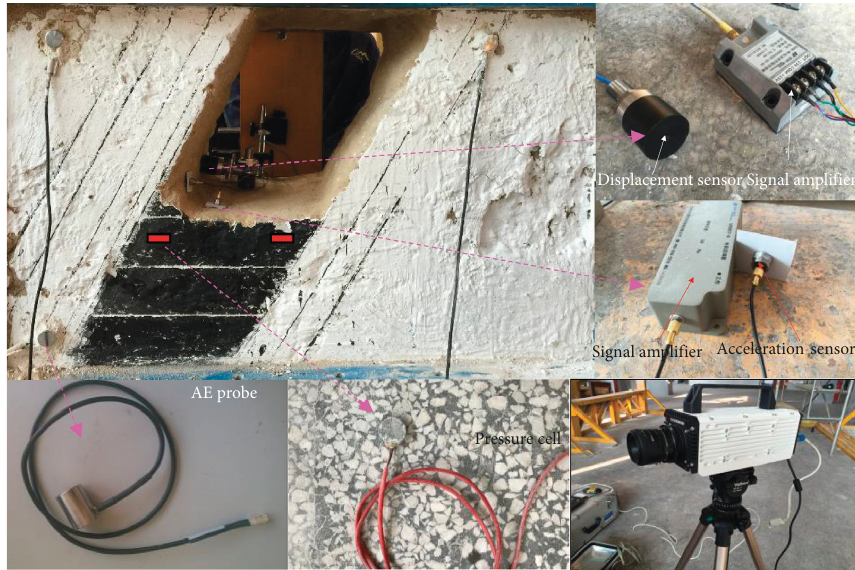
Figure 5: Monitoring equipment and layout.